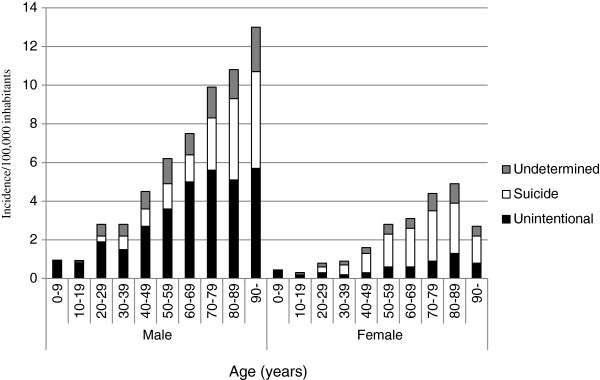
Incidence of drowning deaths per 100,000 inhabitants in relation to age, sex, and manner of death in Sweden from 1992 through 2009. (Homicide drowning (n=21) is not included).